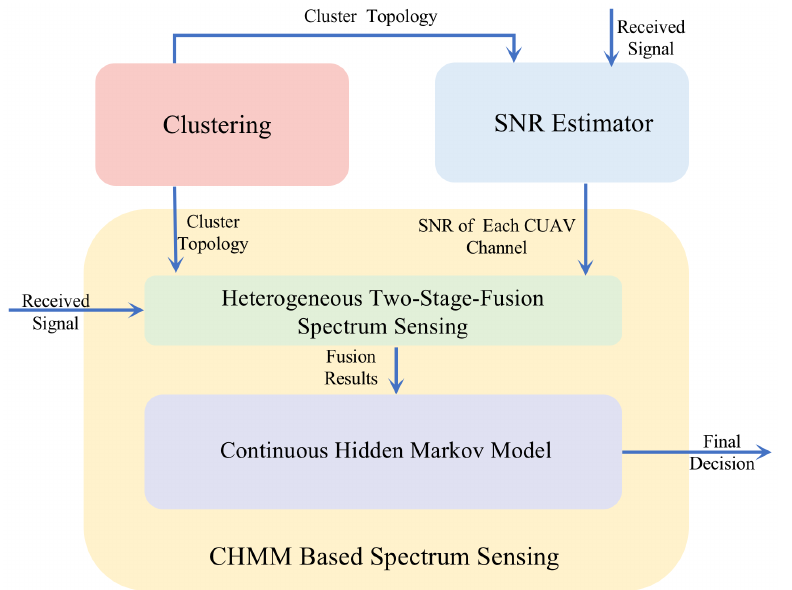
Figure 1. The unified framework of the CHMM-based spectrum sensing scheme with the SS-M2M4